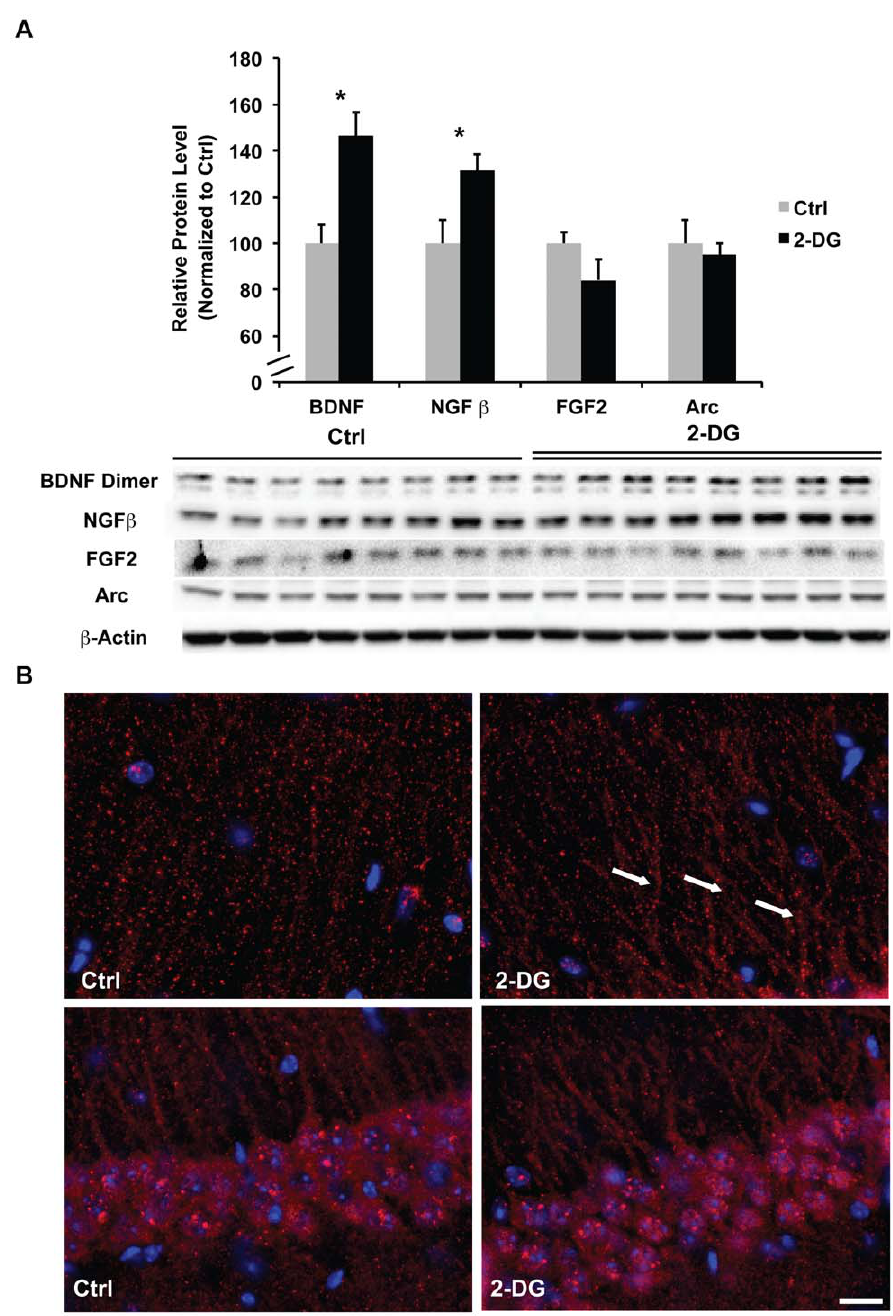
Figure 6. 2-DG increased protein expression of neurotrophic growth factors. Hippocampal homogenate samples from both the Ctrl and 2- DG groups were analyzed for protein levels of BDNF, NGF, FGF2, and Arc. Brain sections were stained for Arc distribution in the hippocampal CA1 region. A, 2-DG induced significant increase in BDNF homodimer and NGF protein levels whereas FGF2 and Arc protein level remained unchanged (*, P , 0.05 compared to Ctrl, bars represent mean values 6 SEM); B, immunofluorescent labeling of Arc protein, upper panel, Arc immunofluorescent labeling in neuronal processes; lower panel, Arc immunofluorescent labeling in peri-nuclear regions (arrows indicates clustered arrangement of Arc immunolabeling in the neuronal processes, scale: 40 m m).